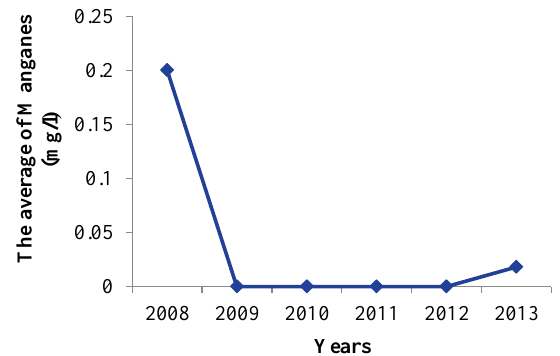
Figure 11. The average of Manganes (mg/l) by year 2008-2013 The average amount of manganese in groundwater, reservoirs, and distribution networks was 0.15, 0.09, and 0.1 mg/l, respectively which was higher than the EPA. 24 Figure 12. The average concentration of Manganes by season 2008-2013